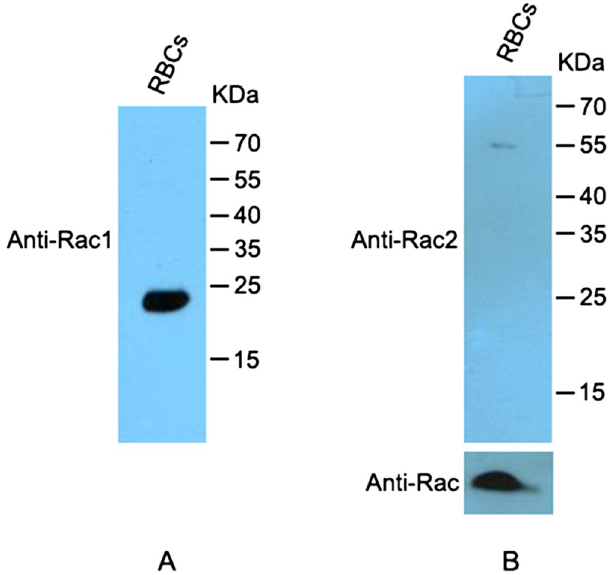
Figure 1. Rac expression in human erythrocytes. ( A ) Proteins extracted from of 5 × 10 7 erythrocyte membranes were hybridized with a monoclonal antibody specific for Rac1 (R1-ab#2). The signal was detected at about 21 kDa, as expected. ( B ) In a different gel, same amounts of erythrocyte membranes were probed with the shown in Fig.